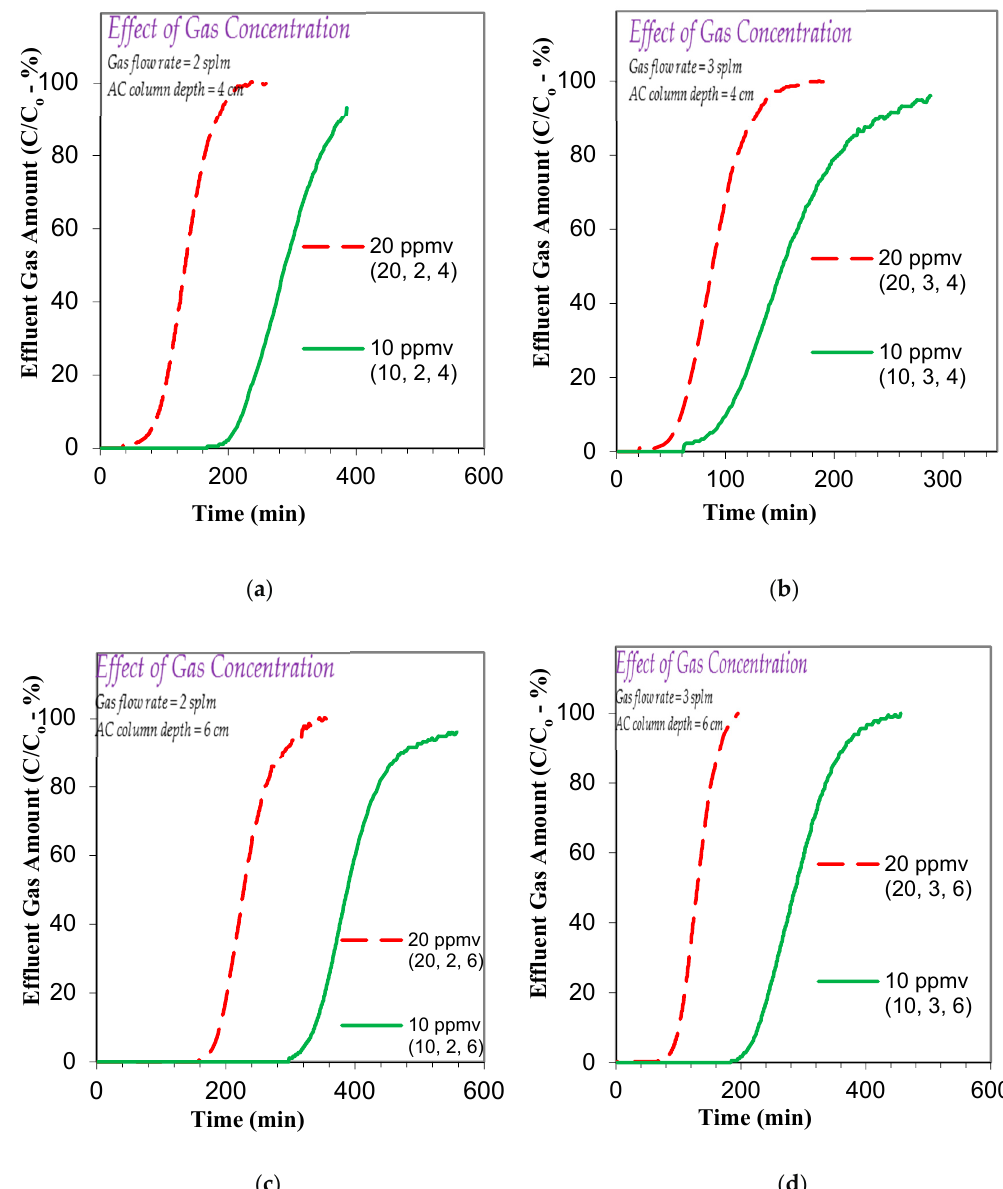
Figure 3. Effect of influent toluene/C 6 H 5 CH 3 gas concentration on the adsorption breakthrough curve profile of toluene/C 6 H 5 CH 3 gas using AC produced from date palm-tree branches ( a ) toluene/C 6 H 5 CH 3 gas flow rate flow rate = 2 slpm; influent gas concentrations 10 and 20 ppmv; AC bed depth = 4 cm; ( b ) toluene/C 6 H 5 CH 3 gas flow rate flow rate = 3 slpm; influent gas concentrations 10 and 20 ppmv; AC bed depth = 4 cm; ( c ) toluene/C 6 H 5 CH 3 gas flow rate flow rates = 2 slpm; influent gas concentrations 10 and 20 ppmv; AC bed depth = 6 cm; ( d ) toluene/C 6 H 5 CH 3 gas flow rate flow rate = 3 slpm; influent gas concentrations 10 and 20 ppmv; AC bed depth = 6 cm; (AC SSA BET = 800.87 m 2 /g and average pore width = 30.32 Å; AC bed dia. 6.35 mm).